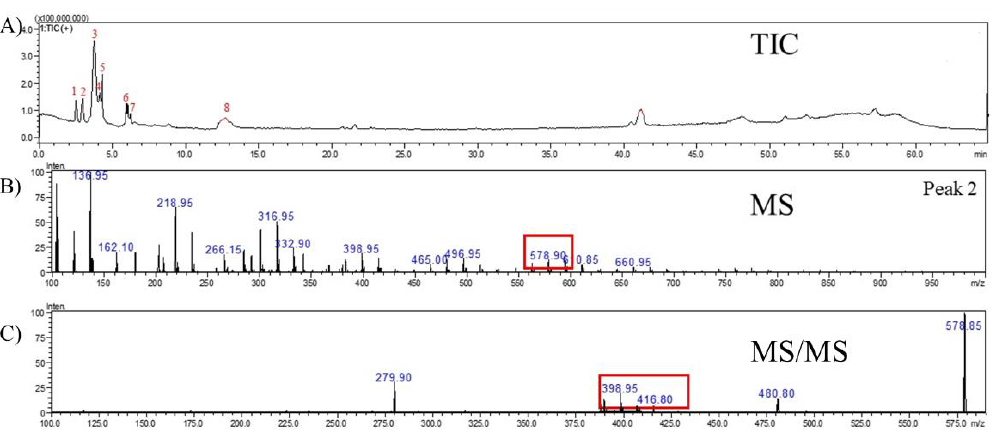
radish at 70 °C for 30 days. 70 ◦ C for 30 days.